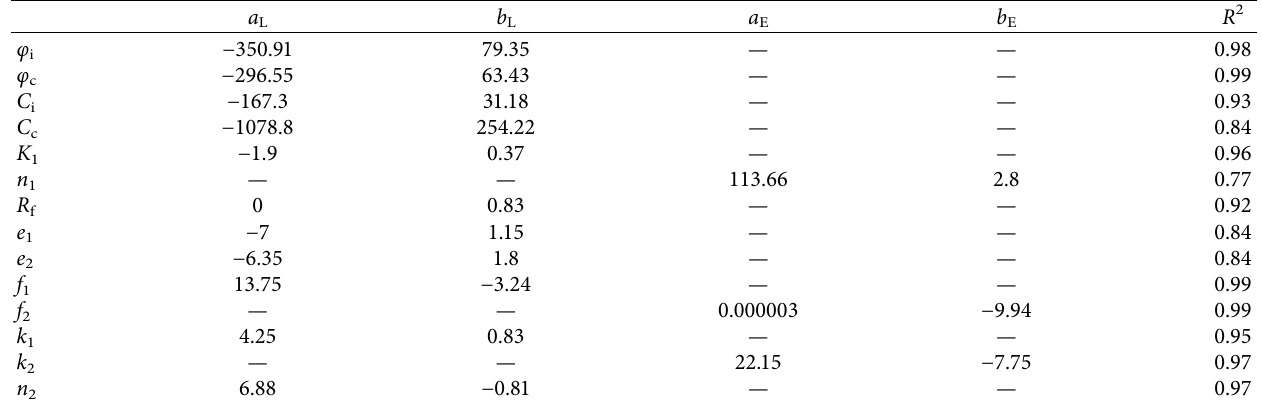
Figure 9: Comparison of test results with model simulations. (a) w � 12.5%, (b) w � 14.5%, (c) w � 16.5%, and (d) w � 18.5%. Table 4: Best-fitting relationship between model parameters and water